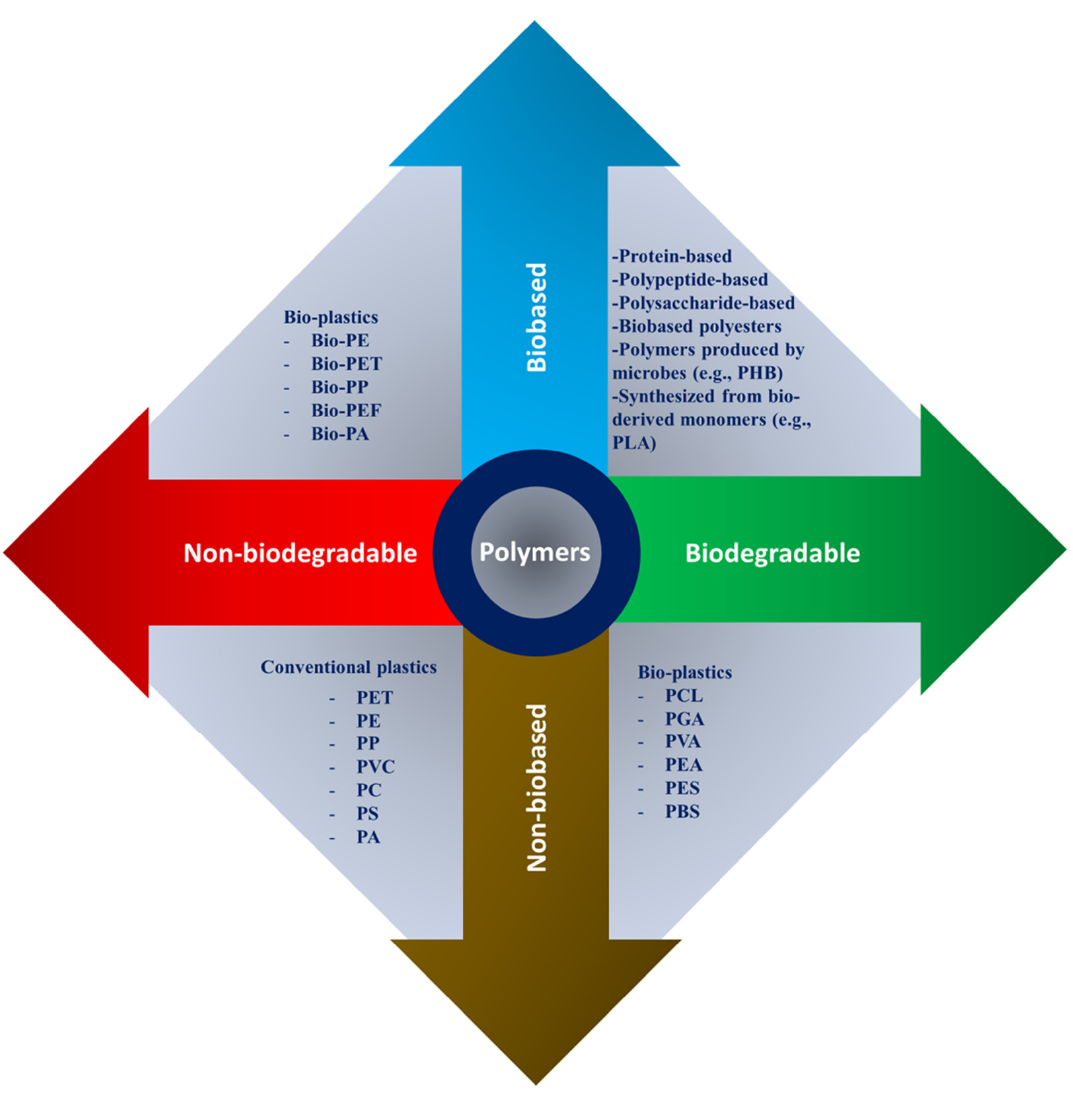
Figure 2. Natural and synthetic polymers were rearranged based on bio vs non-bio and biodegradable vs nonbiodegradable characteristics, where PHB: polyhydroxybutyrate; PLA: polylactic acid; PCL: polycaprolactone; PGA: poly(glycolic acid); PVA: poly(vinyl alcohol); PEA: poly(ethylene adipate); PES: polyethersulfone; PBS: polybutylene succinate; PET: polyethylene terephthalate; PE: polyethylene; PP: polypropylene; PVC: polyvinyl chloride; PC: polycarbonate; PS: polystyrene; PA: polyamide; and PEF: polyethylene furanoate.